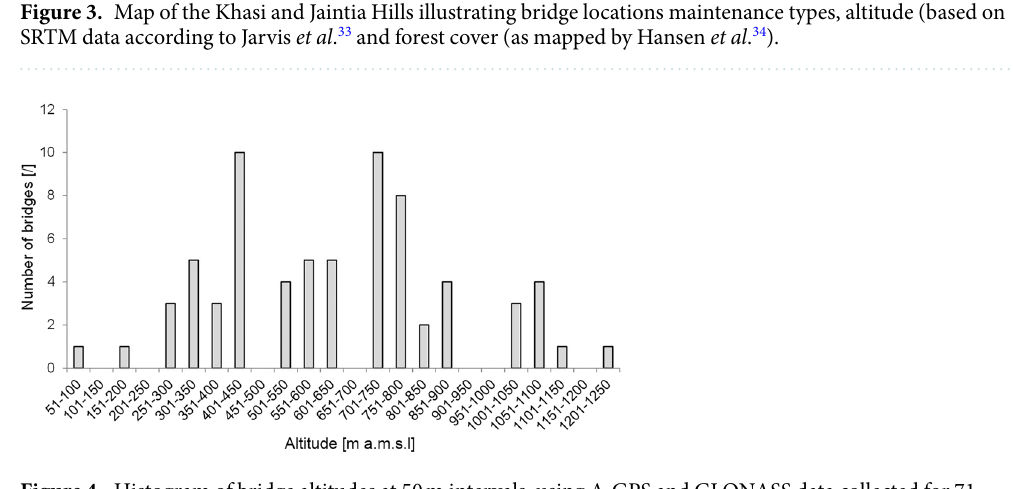
Figure 4. Histogram of bridge altitudes at 50 m intervals, using A-GPS and GLONASS data collected for 71